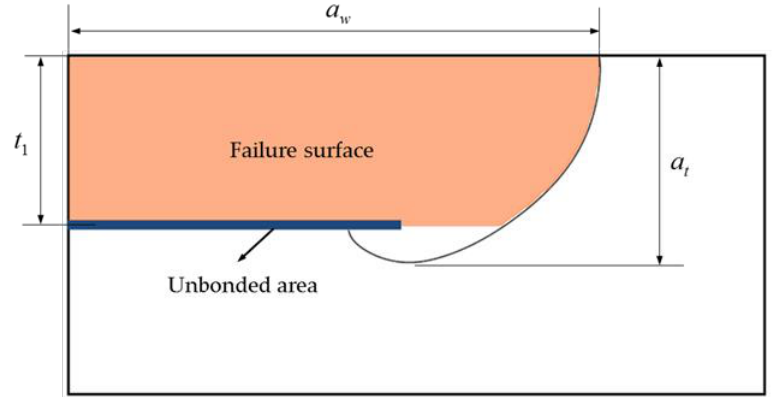
Fig.6 Schematic diagram of the parameters Figure 6. Schematic diagram of the